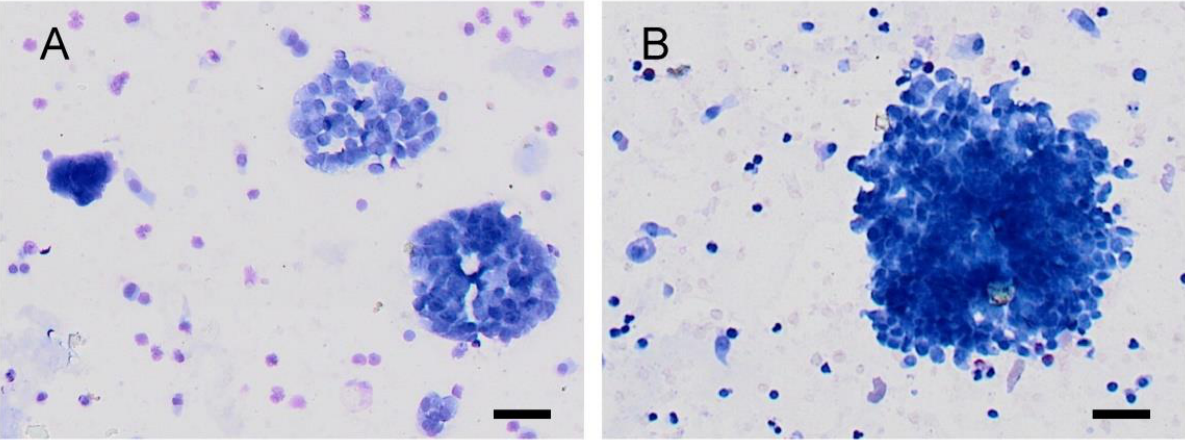
Figure 1. Urine cytology from a healthy volunteer (category shift from TPS2 to TPS3). ( A ): In naive urine (TPS2-negative for high-grade urothelial cancer), the cells are better seen, with uniform nuclei and fine chromatin. ( B ): In the postcontrast urine (TPS3–atypia), the visibility of cell clusters is clearly worse. Nuclei appear hyperchromic, and in some cells, notches in the karyomembrane are also visible. A scale bar represents 50 µ